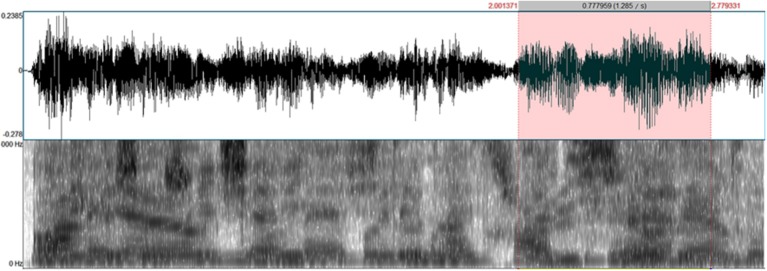
Example of a spectrogram and a wave form of a 2SC/2SI condition stimulus. Red part corresponds to the occurrence of the target word.